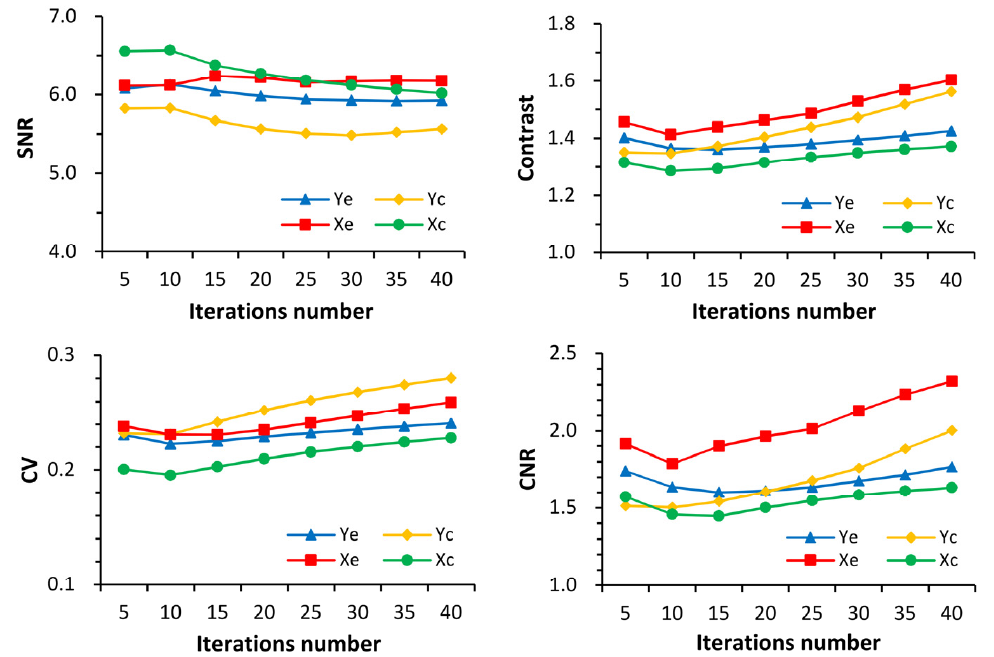
Figure 5. The SNR, contrast, CV, and CNR of PET images reconstructed by the MLEM algorithm in different orientations and positions are plotted as a function of the iteration number.